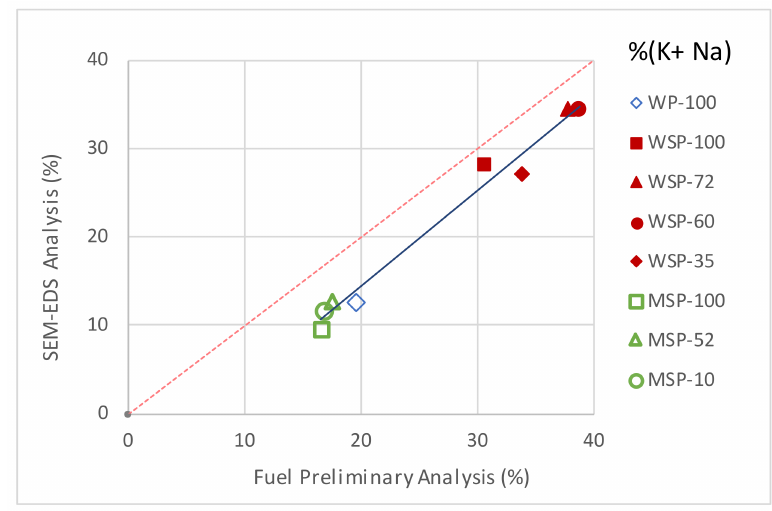
Figure 3. K + Na concentration in bottom ash versus K + Na concentration in fuel preliminary